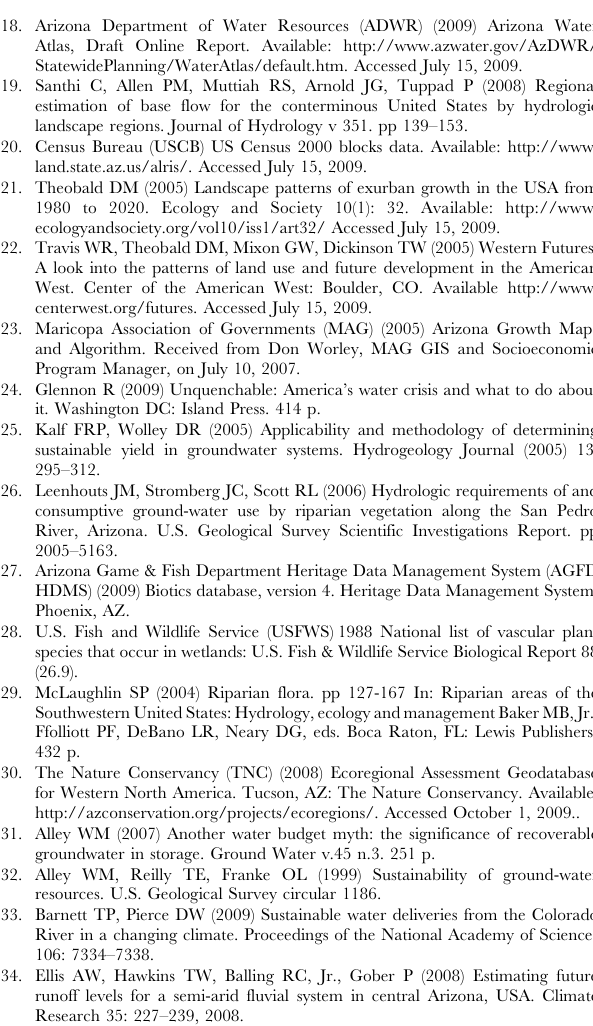
Table S1 Population, base flow, and municipal water demand under four scenarios for eighteen river basins in Arizona. Provides baseline data used for estimating population growth, water demand, river flows, and the values used in scenarios.